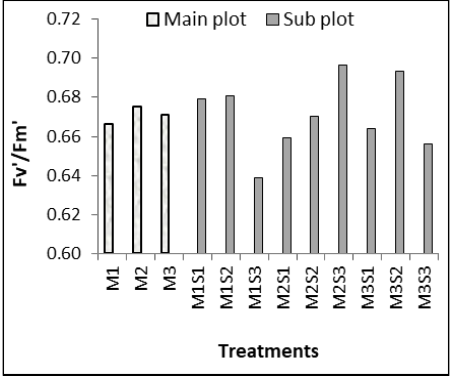
Figure-4 Fv ' /Fm ' vs